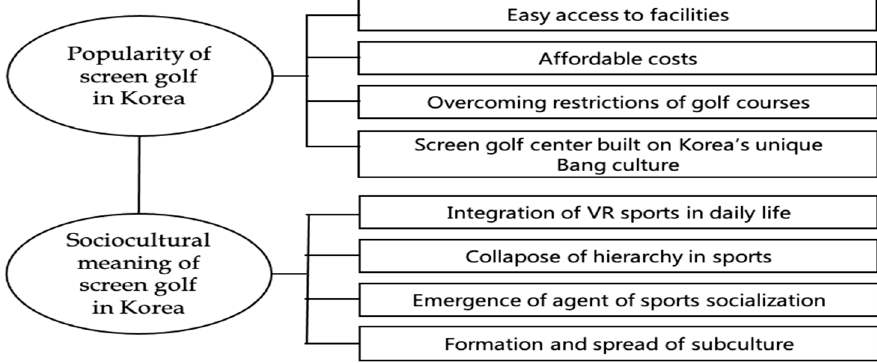
Figure 1. Results presentation.